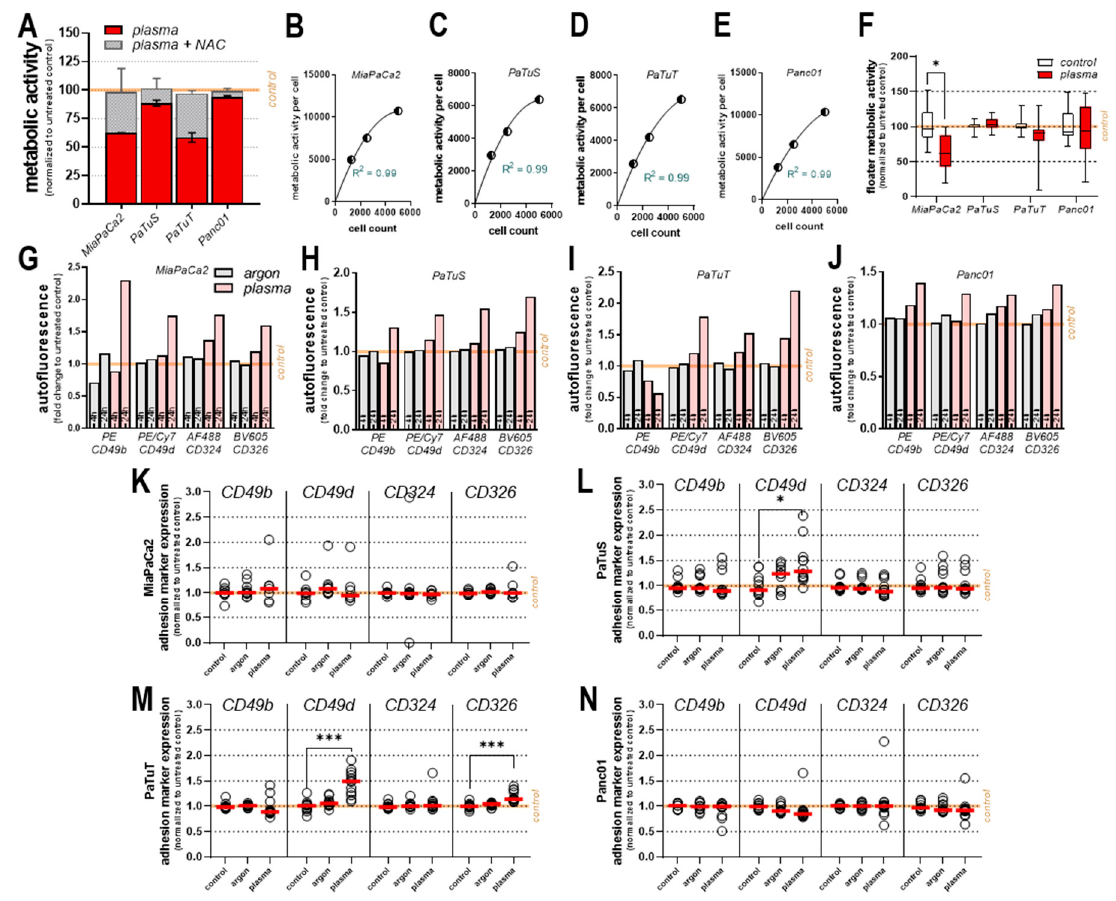
Figure A1. Plasma treatment affected cellular morphology and expression of early adhesion markers, and plasma’s toxicity is quenched with scavenger n-acetylcysteine. ( A ) decrease of metabolic activity 24 h after exposure to physical plasma and alleviation of toxic plasma effect upon pre-incubation with n-acetylcysteine (NAC); correlation of metabolic activity and viable cell count for ( B ) MiaPaCa2, ( C ) PaTuS, ( D ) PaTuT, and ( E ) Panc01 cells with goodness of fit (R 2 ) of different polynomial functions of the 2nd degree (quadratic); ( F ) metabolic activity normalized to respective untreated controls of detached cells in supernatant following treatment (floaters) subsequently allowed for proliferation in another plate for 6 days; fold change of autofluorescence 4 h and 24 h after treatment with argon gas or plasma for 60 s in channels for PE, PE/Cy7, AF488, and BV605 for ( G ) MiaPaCa2, ( H ) PaTuS, ( I ) PaTuT, and ( J ) Panc01 cells; fold change of adhesion marker expression 4 h post-treatment normalized to untreated control and corrected for autofluorescence for ( K ) MiaPaCa2, ( L ) PaTuS, ( M ) PaTuT and ( N ) Panc01 cells. Data are mean + SEM ( A ), mean ( B – E, G – J ), mean and single values ( K – N ) or median with minimum, maximum and SEM ( F ) of representative data ( A ) or several independent replicates ( B – N ).